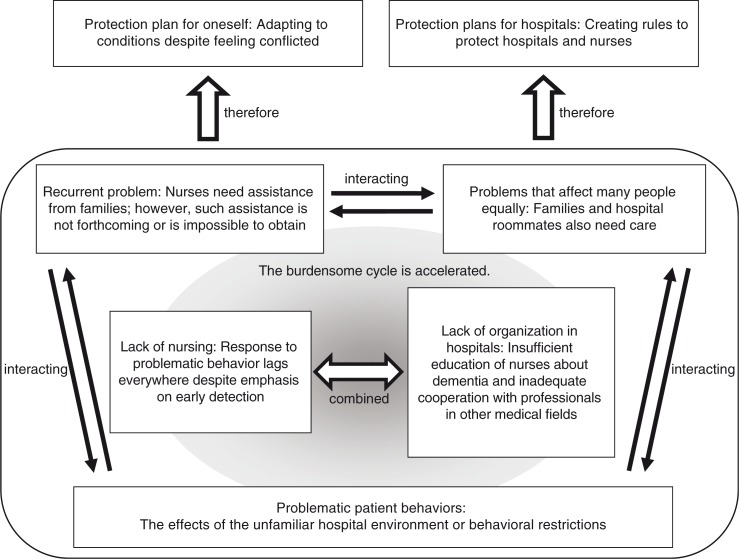
Schematic diagram of the issues faced by nurses caring for patients with dementia in acute care hospitals.